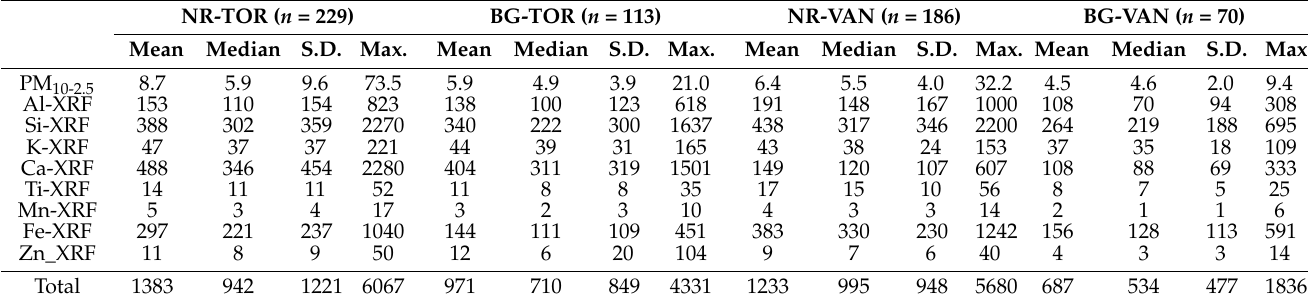
Table 3. Summary statistics for PM 10-2.5 (in µ g m − 3 ) and elemental concentrations (in ng m − 3 ) at Toronto and Vancouver